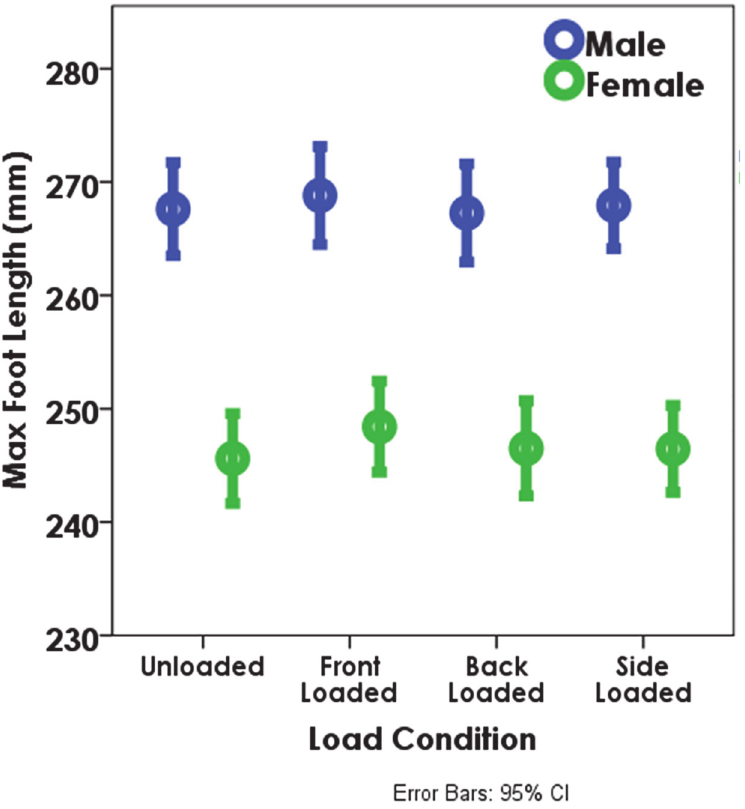
Fig 4. The increase in maximum foot length (MFL) at each of the loaded conditions by sex (all speeds combined). The circles denote the means and the error bars represent the 95% confidence intervals. MFL was consistent across all loading conditions for males. For females, the difference between the unloaded and front loaded condition is significant (p <